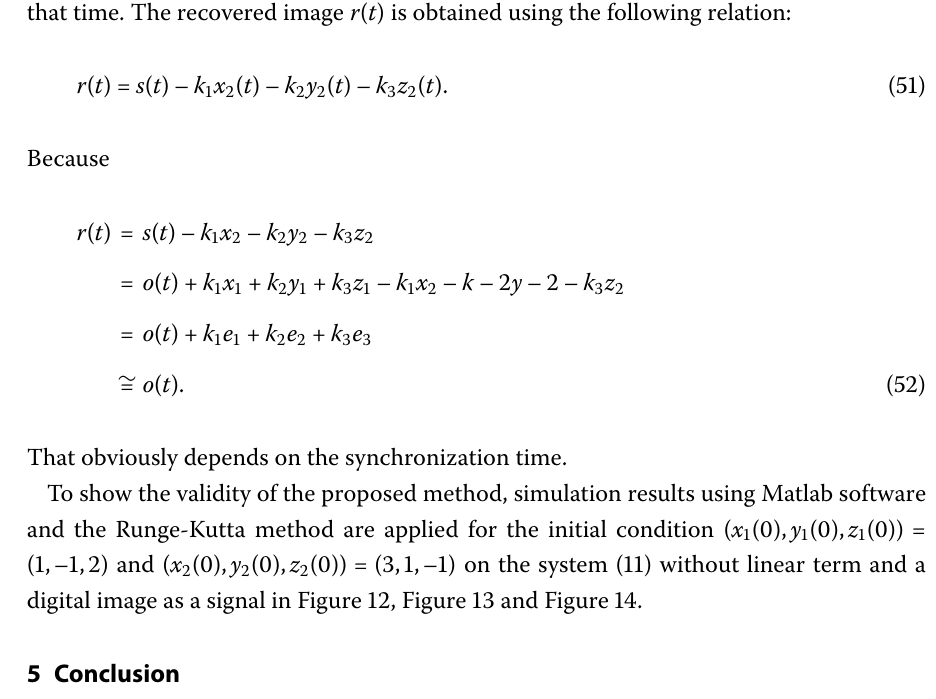
Figure 13 Received signal